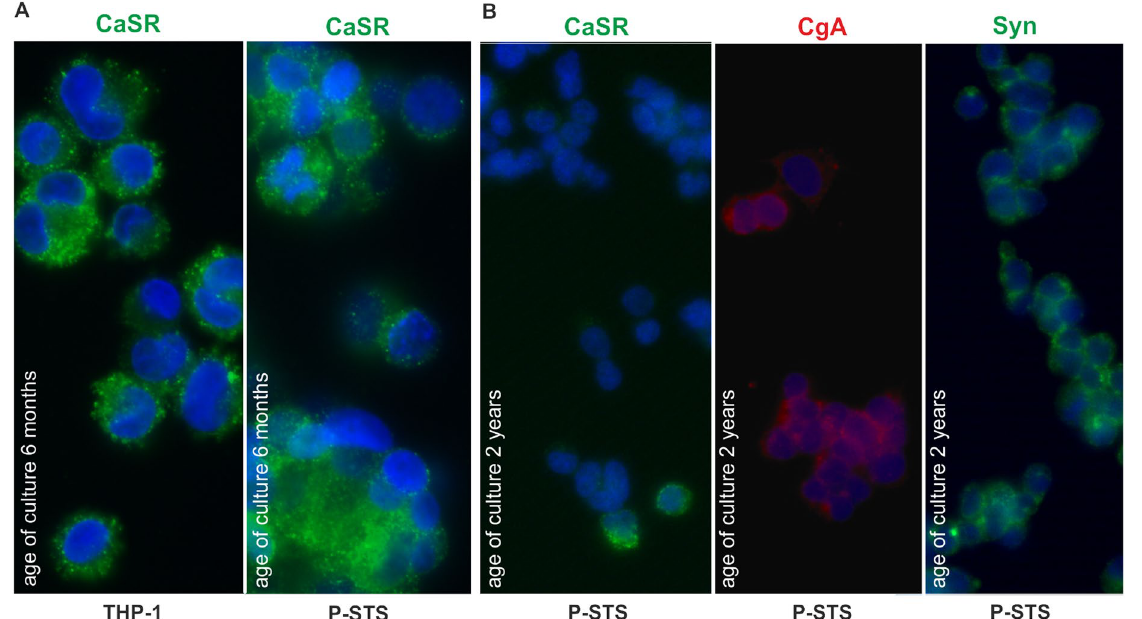
Figure 3. Expression of CaSR by P-STS cells. ( A ) Immunofluorescence staining with anti-CASR (Alexa 488-labeled secondary antibody) of THP-1 cells grown with 200 nM PMA for 2 d (control) and P-STS cells after 6 months of continuous cultivation. ( B ) Immunofluorescence staining with anti-CASR (Alexa 488-labeled secondary antibody), anti-CgA (Cy3-labeled secondary antibody) and anti-synaptophysin (Alexa 488-labeled secondary antibody) of P-STS cells after 2 years of continuous